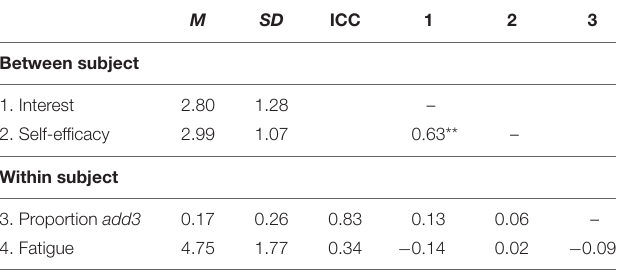
TABLE 2 | Descriptive statistics for Study 2.